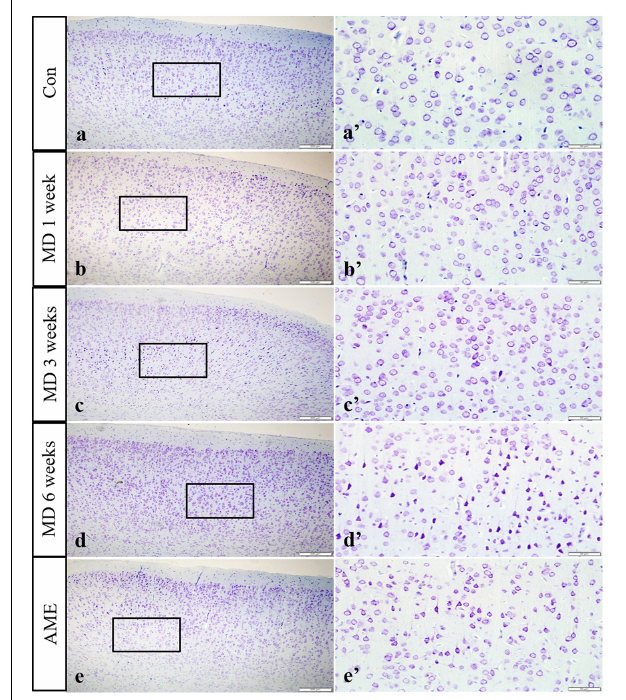
FIGURE 3 | Thionine staining of the cortex. Panels (a’–e’) are magnified areas of panels (a–e) , respectively. With increasing periods of morphine dependence, Nissl body structures are not clear, and neurons are pyknotic and deeply stained. Bars = 200 µ m in panels (a–e) . Bars = 50 µ m in panels (a’–e’) ; MD, morphine dependence; AME, acute morphine